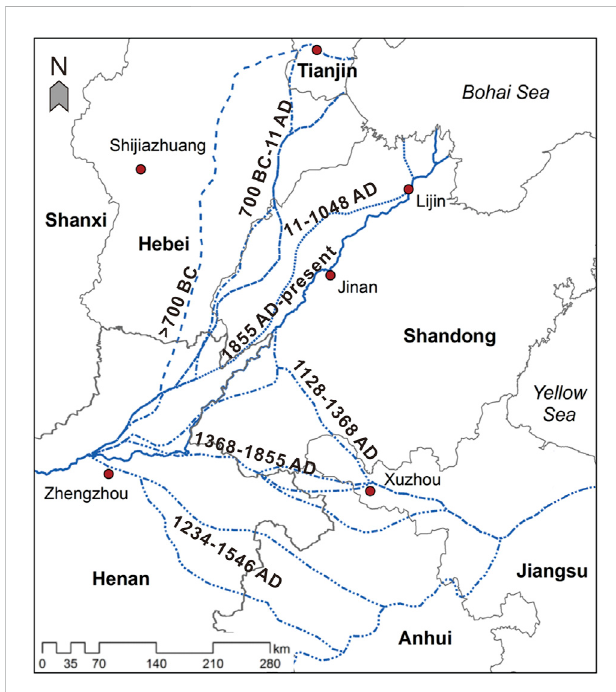
FIGURE 2 RiverdiversionoftheLowerYellowRivercourseinrecordedhistory modi fi ed from Xue et al. (2003), Wang and Su (2013). Despite the Yellow River changing its course southward to Yellow Sea several times, the overall fl owing time is limited between 1128 and 1855